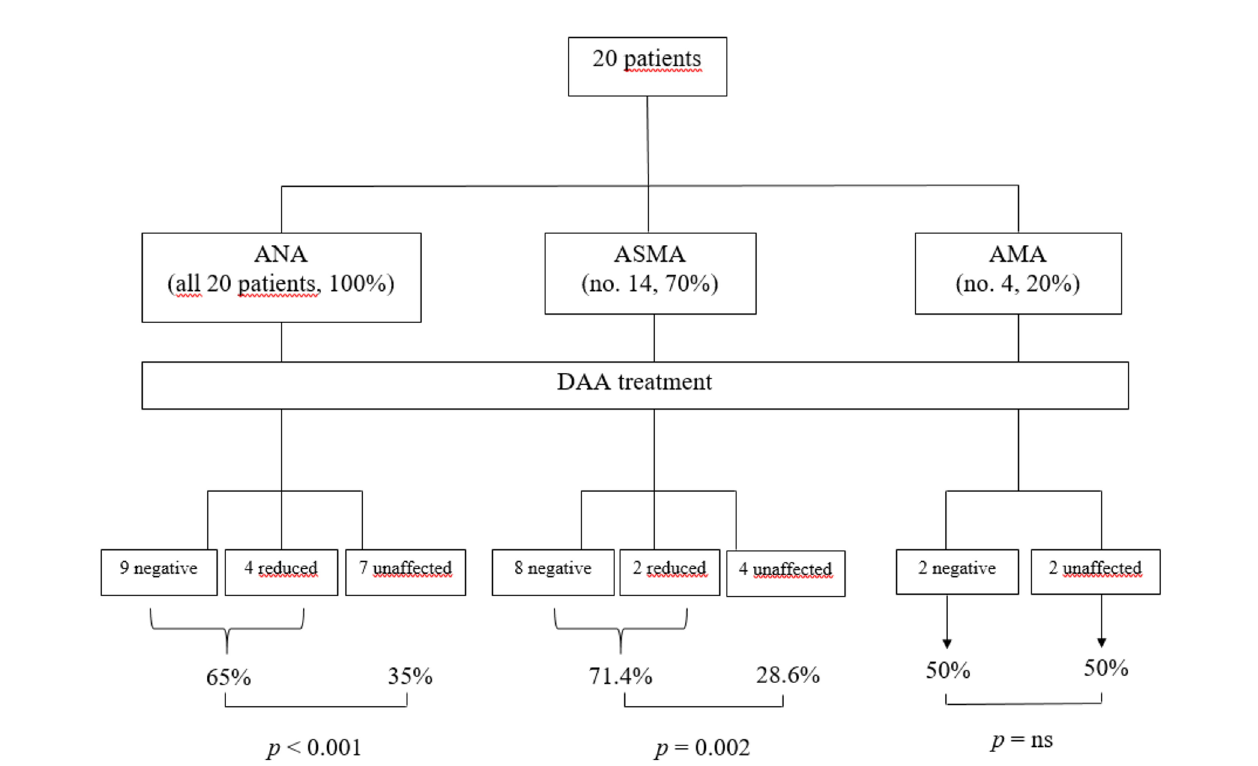
FIGURE 3 | Outcome of serological autoimmunity after DAA treatment.